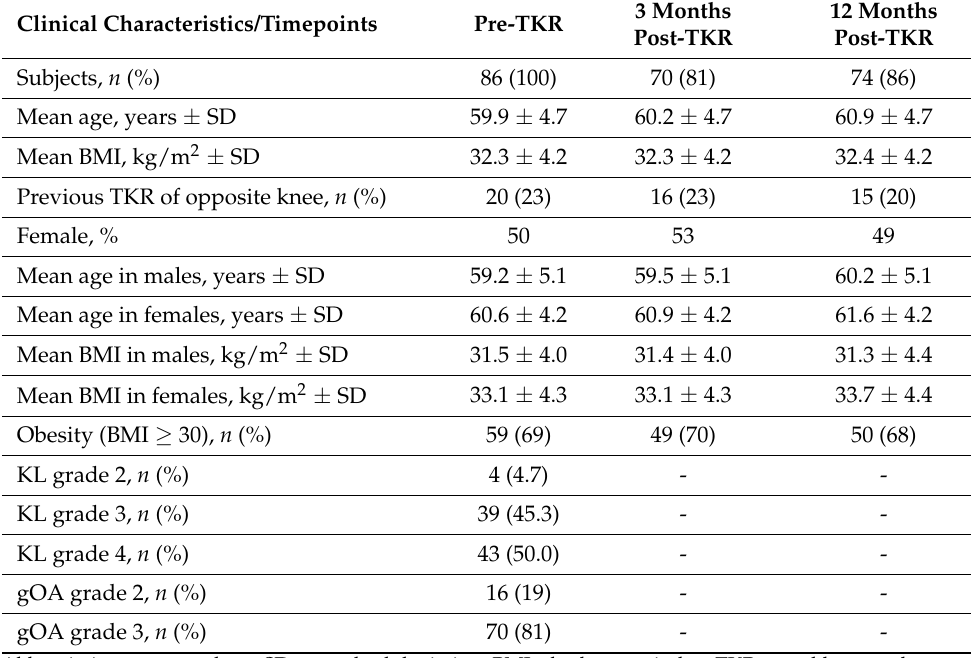
Table 1. Clinical characteristics of the study cohort by